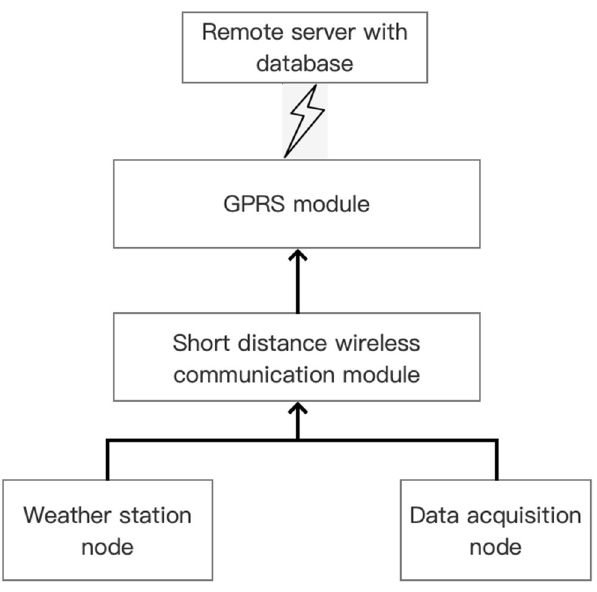
Figure 2. Structure of citrus orchard IoT system.